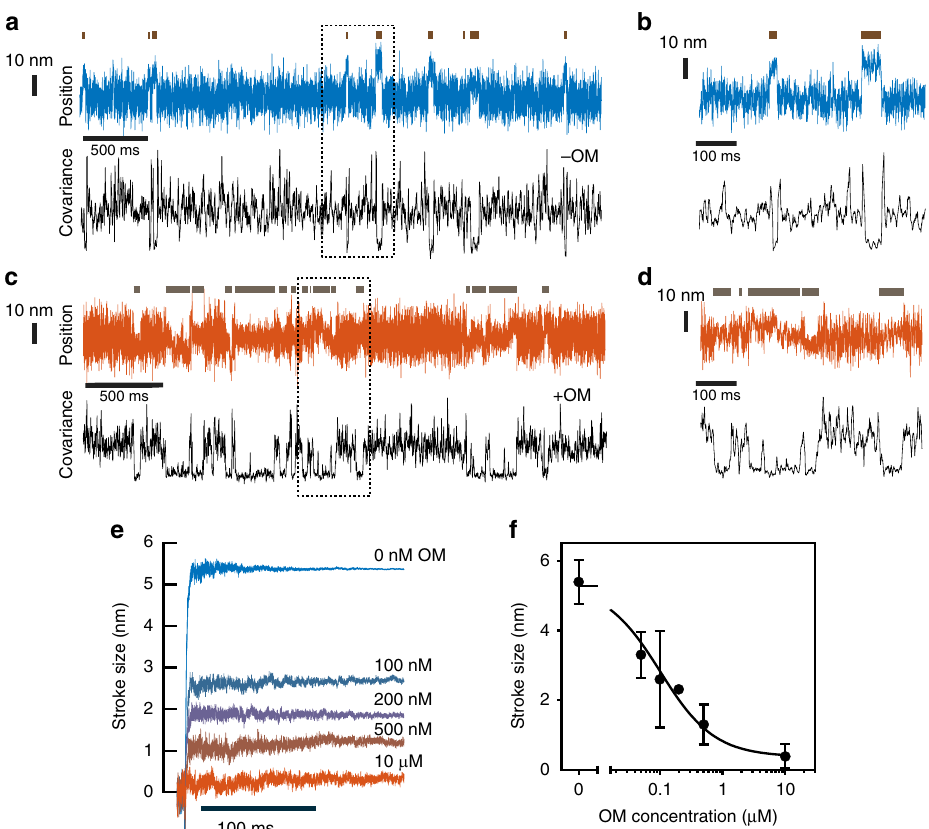
Fig. 2 The effect of OM on myosin working stroke size. a Example trace of the position of one bead during several interactions of cardiac myosin with actin in the absence of OM (blue). The covariance of the two beads ’ positions is shown in black and was used to determine when a binding event occurred, as indicated by the dark horizontal lines above the position trace. b An expanded section of the data inside the dashed box in a , where two clear interactions can be visualized. c , d Example trace similar to that in a and b , but with 10 μ M OM present. The interactions are more dif fi cult to distinguish in the position trace (red) but are clear from the covariance (black). Position traces in a – d are median fi ltered with a 0.4 ms window. e Binding events were synchronized at their starts and averaged forward in time to show the average stroke size observed in the presence of OM ranging from 0 to 10 μ M. Average stroke size decreases with increasing OM concentration. f The average observed stroke size was decreased by OM in a dose-dependent manner. Error bars give the standard deviation of the mean step sizes from each molecule observed. N -values are presented in Supplementary Table 1